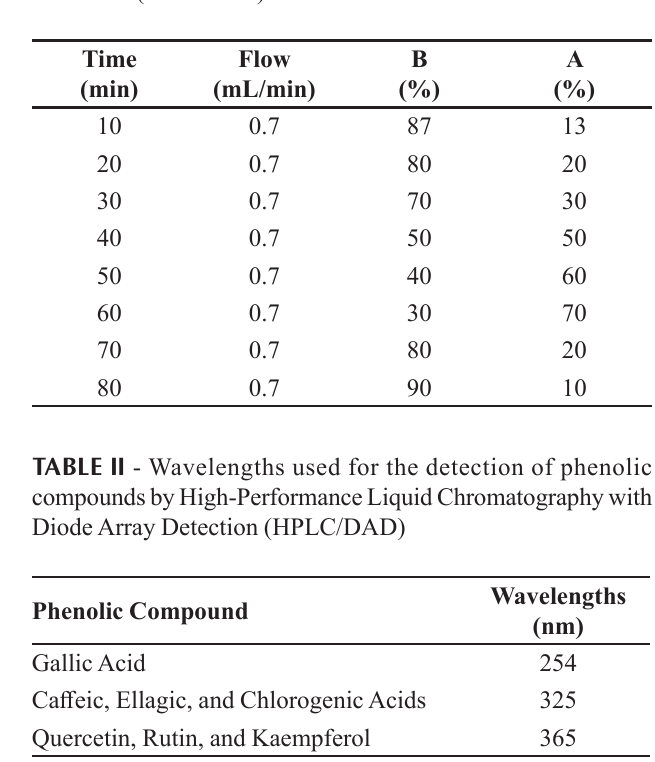
TABLE I - Gradient elution used for the evaluation of lyophilized aqueous extract (LAECs) and precipitate obtained from the raw ethanol extract (Cs1). Solvent A (1% formic acid in water).